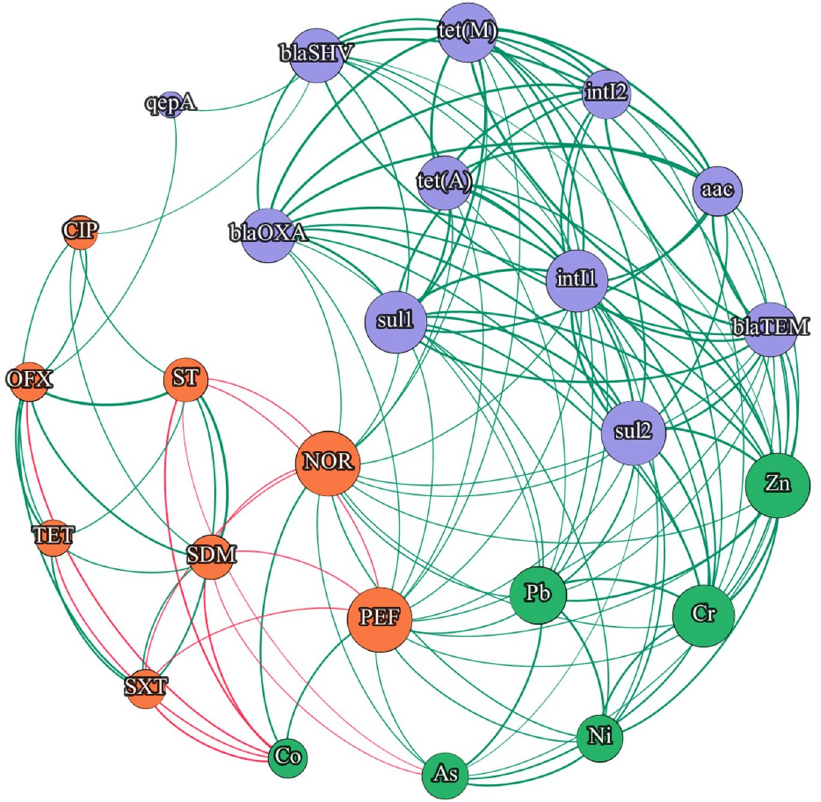
Fig 7. Network analysis of correlated variables in WM-WWTP. All correlations in diagram are statistically significant. Edges: green—positive correlations, red—negative correlations; Nodes: green—heavy metals, purple— genes,